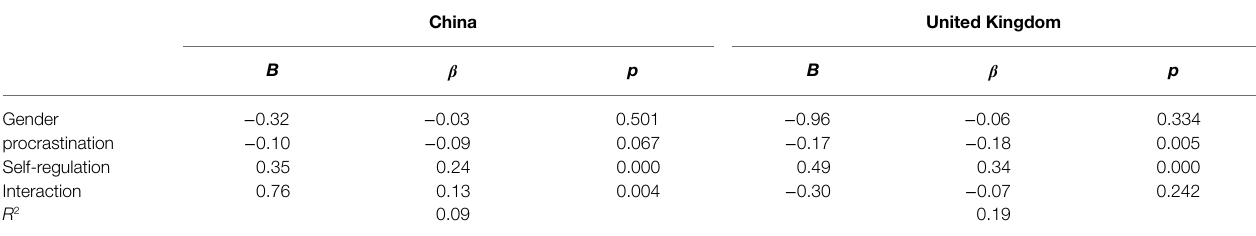
TABLE 3 | Regression coefficients for life satisfaction in China and the United Kingdom.